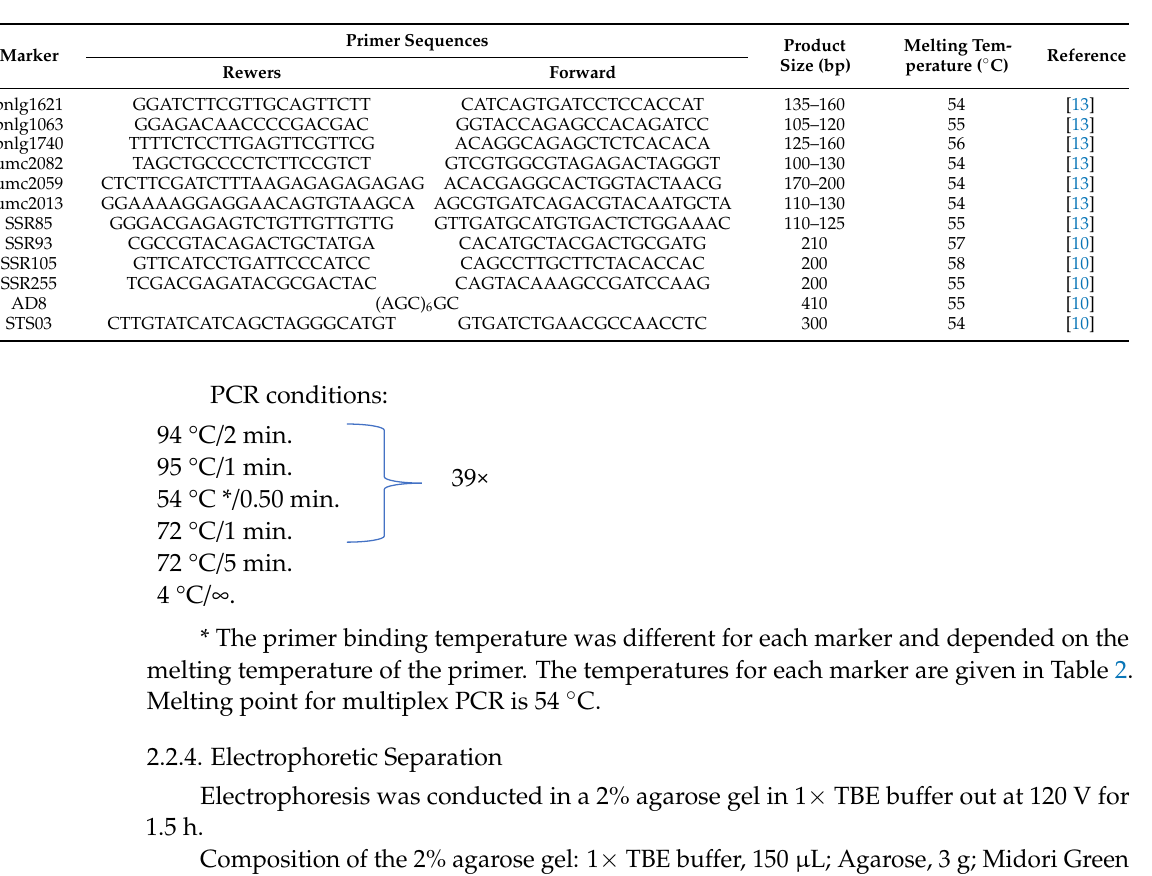
Table 2. Molecular markers associated with F. verticillioides resistance genes for maize.